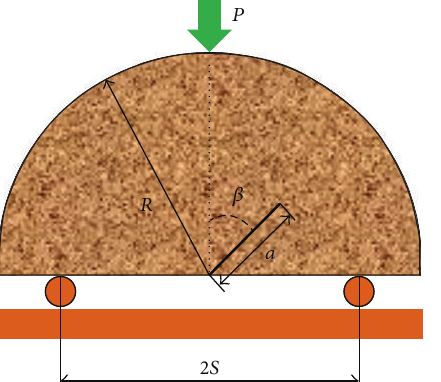
Figure 1: Fracture testing configuration of the SCB specimen.